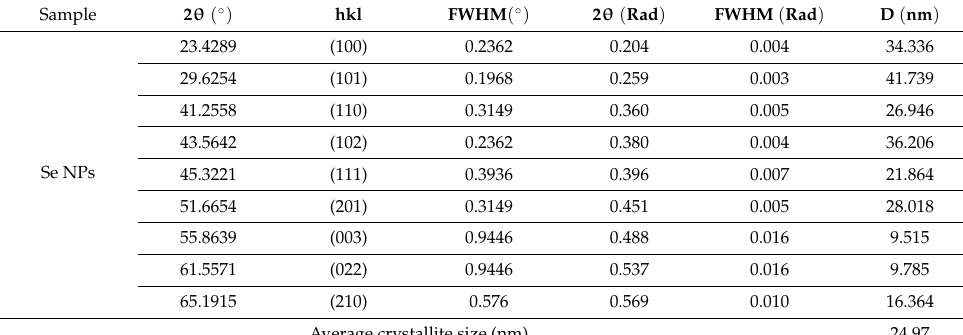
Table 2. The crystallite size of Se